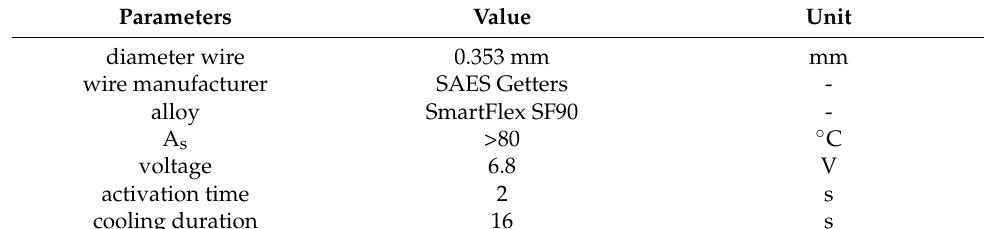
Table 5. Parameters used for the wire and activation of the prototype actuator.